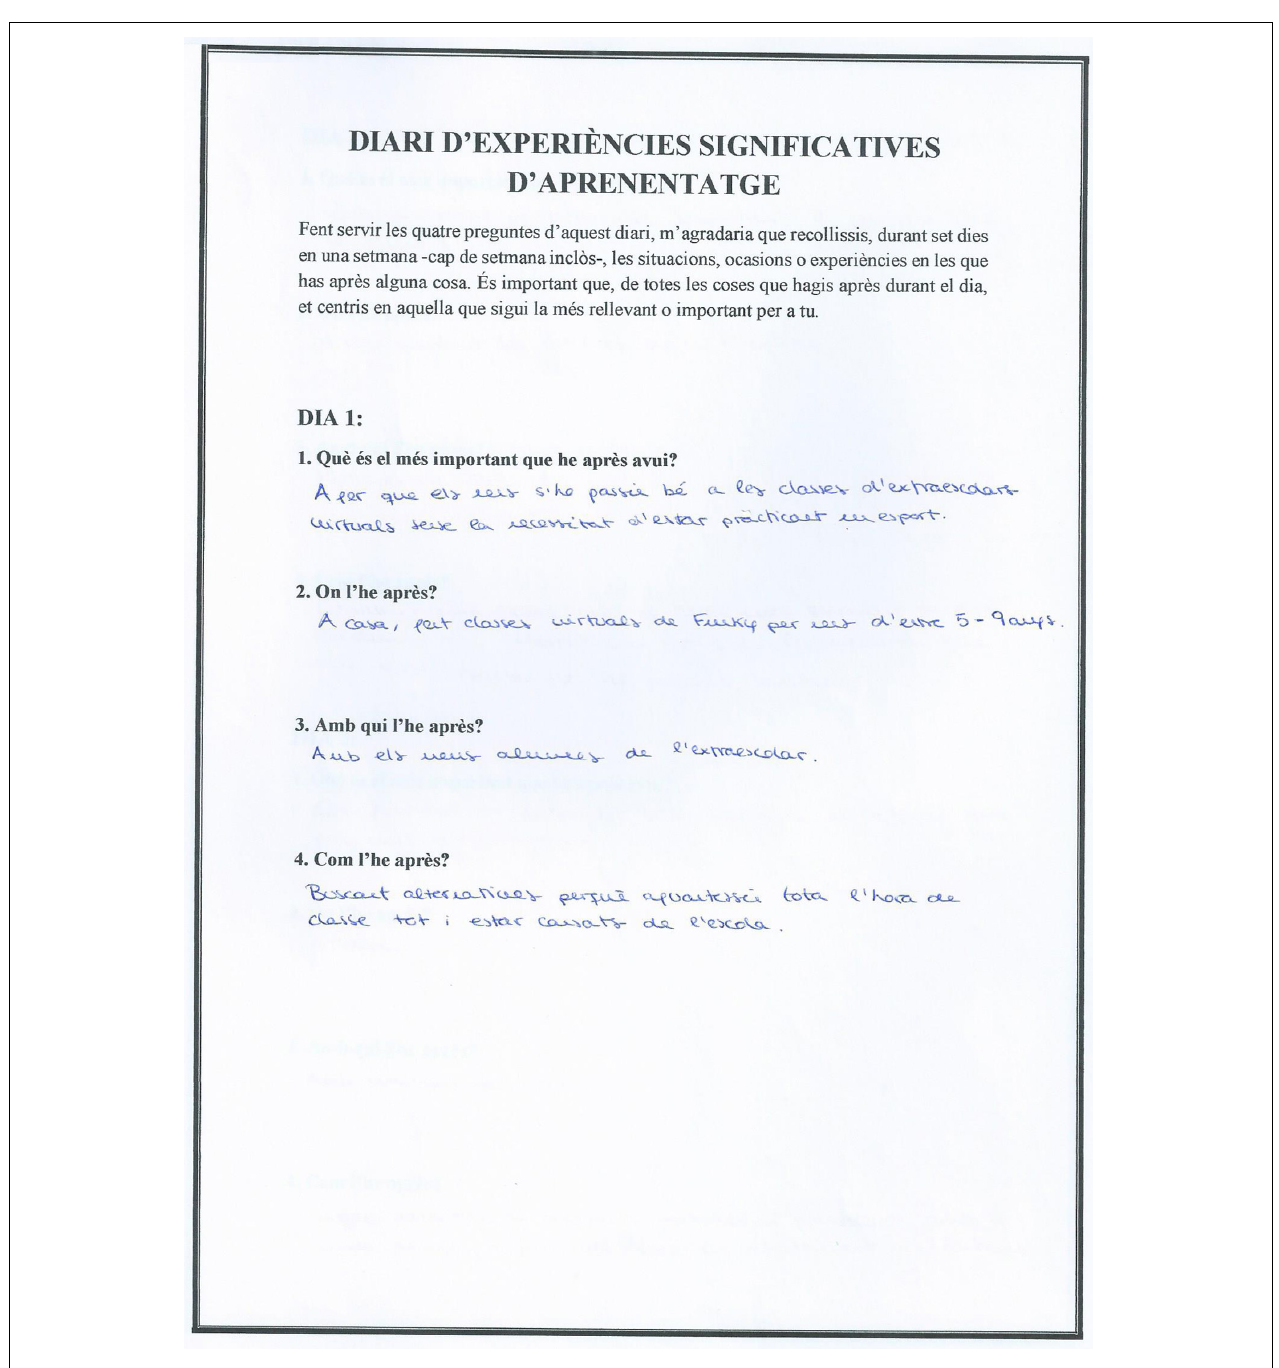
FIGURE 1 | Example of a personal diary of meaningful learning experiences.